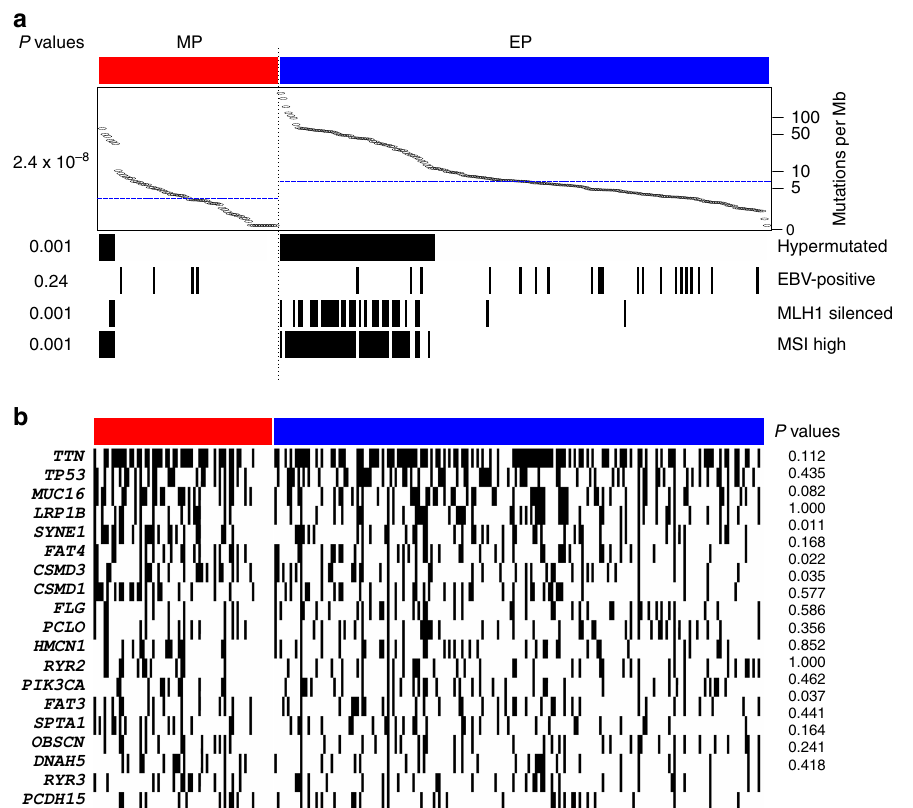
Fig. 5 Genomic landscape of mesenchymal phenotype (MP) and epithelial phenotype (EP) subtypes of gastric cancer. a Genomic and histologic data were retrieved from The Cancer Genome Atlas project database and analyzed ( n = 262). Tumors with greater than 11.4 mutations/Mb were classi fi ed as hypermutated tumors. ALL P values were obtained using χ 2 tests except for mutation rates. P values for mutation rates were obtained using Student ’ s t -test (two-sided). b Mutational landscape of two subtypes in TCGA cohort. Most frequently mutated genes in TCGA data are presented (20